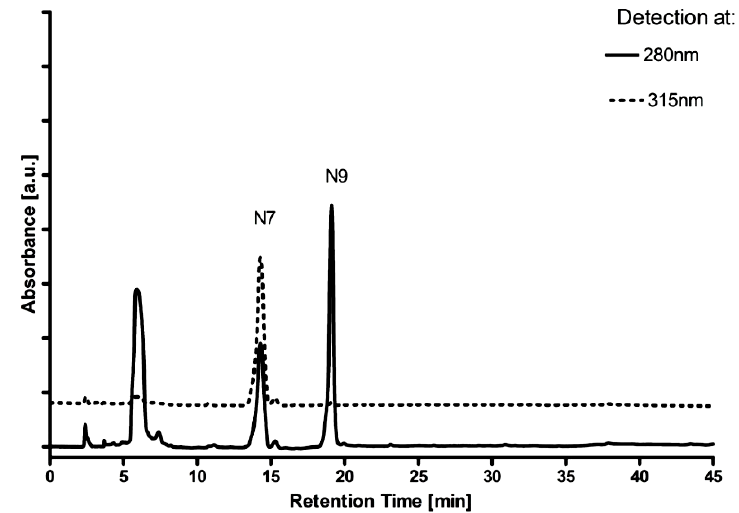
Figure 2. The HPLC elution profile for the mixture obtained from the ribosylation of 8-azaguanine with α - D -ribose-1-phosphate as a ribose donor, catalyzed by the N243D mutant of the calf PNP. The Kromasil C8 column (5 µm × 250 × 10 mm) was used, and the reaction mixture eluted with water (10 min) followed by 0%–30% methanol gradient. The first peak (~6 min retention time) was identified as unreacted 8-azaguanine.